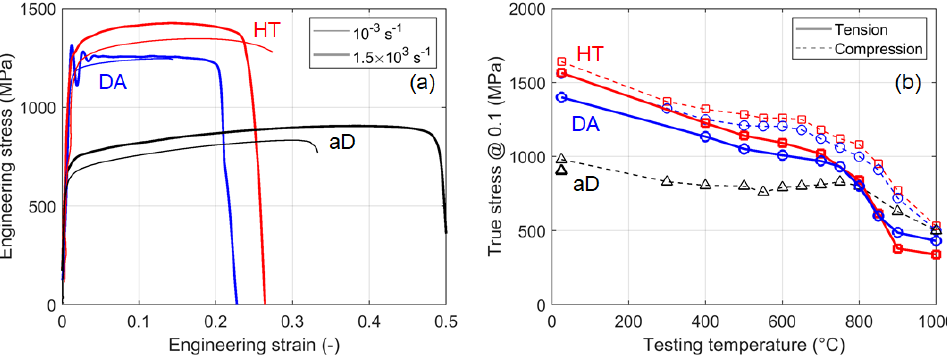
Figure 9. ( a ) Engineering stress versus engineering strain curves at room temperature in quasi-static and high strain rate conditions for aD, DA, and HT specimens; ( b ) true stress as a function of the testing temperature at 0.1 of true strain: comparison between tension and compression results.